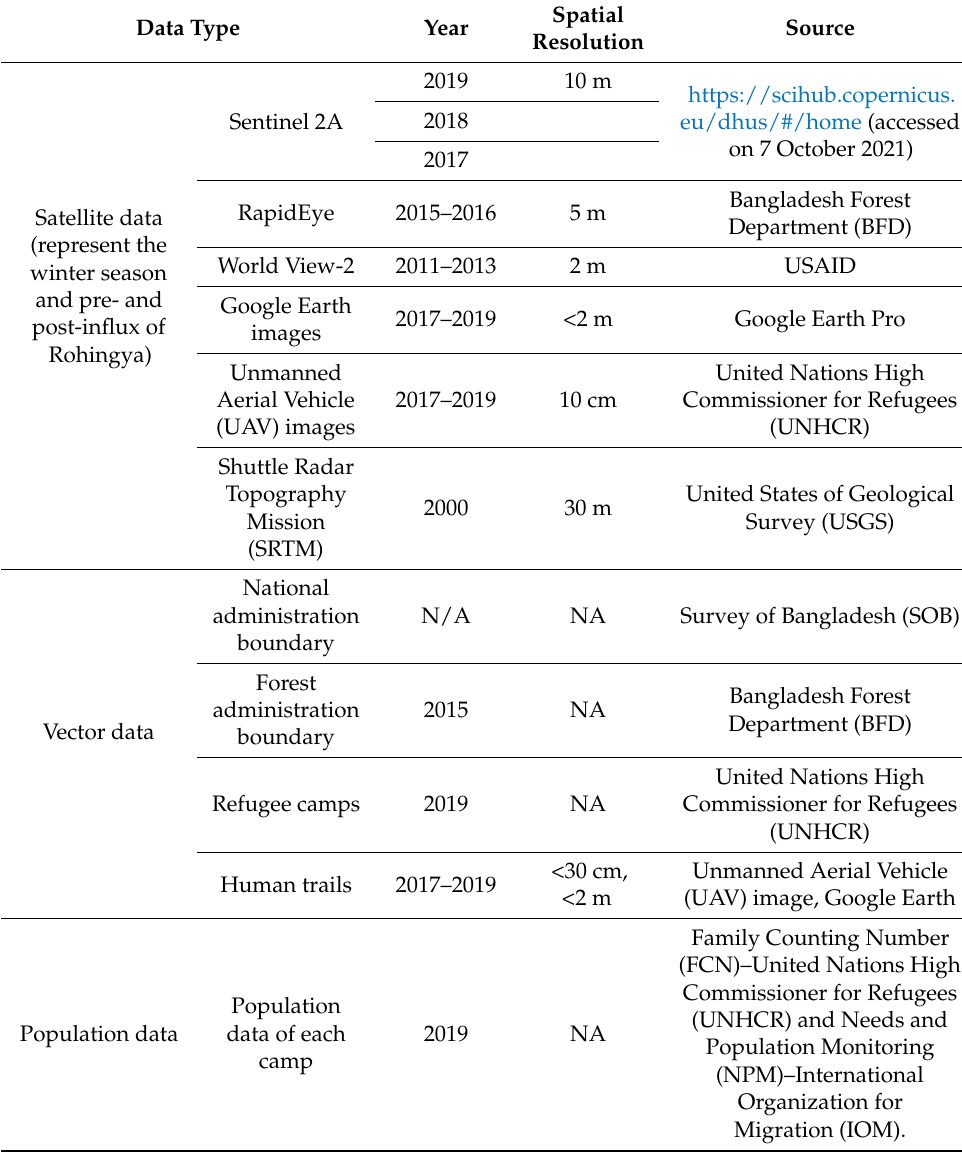
Table 1. Types of data used in this